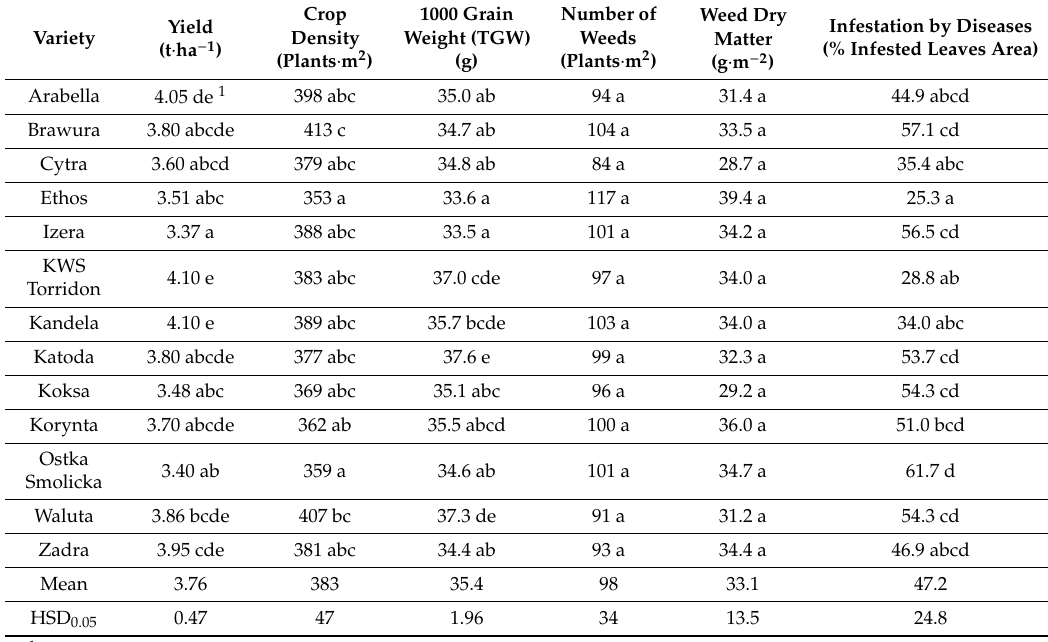
Table 2. Average grain yields and associated traits for spring wheat varieties from 3 years of research (2014–2016) and 3 experimental locations ( n =